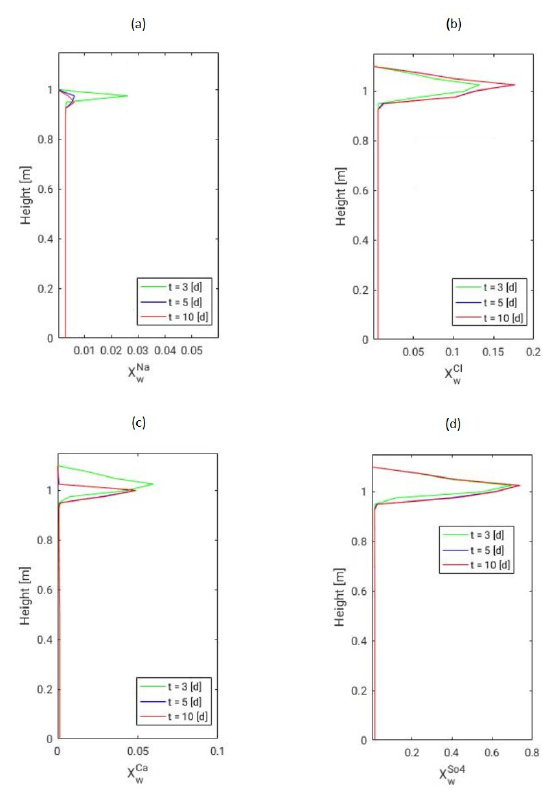
Figure 9. Mass fraction distribution of different ionic species ( a ) Na + , ( b ) Cl − , ( c ) Ca 2 + and ( d ) SO 2 − dissolved in the saline water. The concentration distributions are depicted along a vertical section in the top region of the porous medium domain and are plotted after several days for each ionic